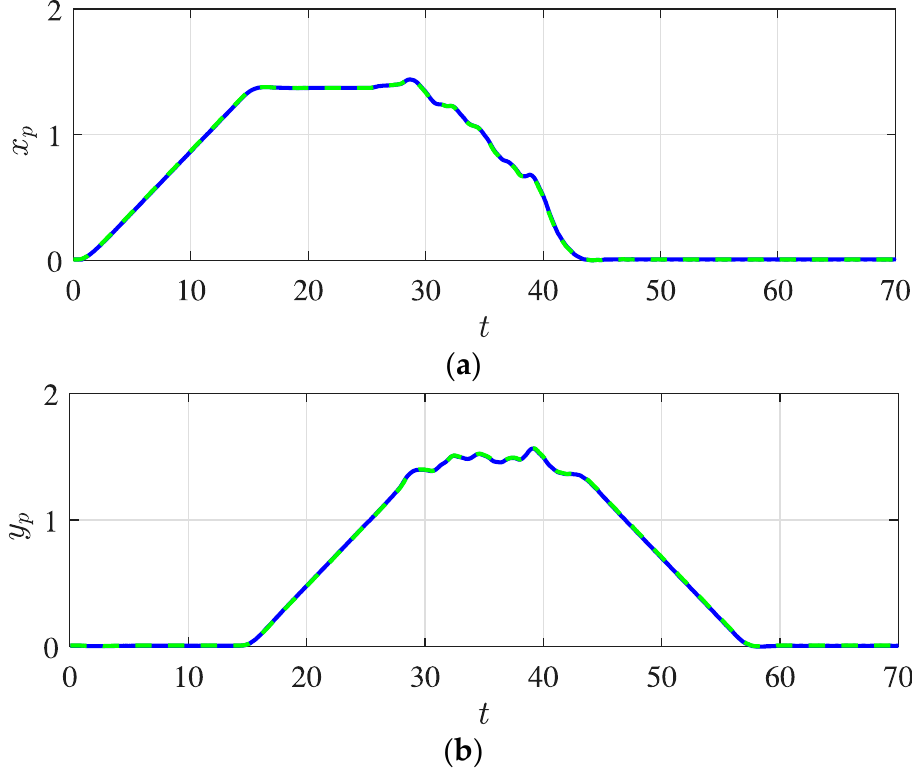
Figure 17. Lateral payload trajectory using RDO (where ( a ) x axis and ( b ) y axis), showing the current (solid blue line) and estimated (dashed green line) paths of the payload trajectory.